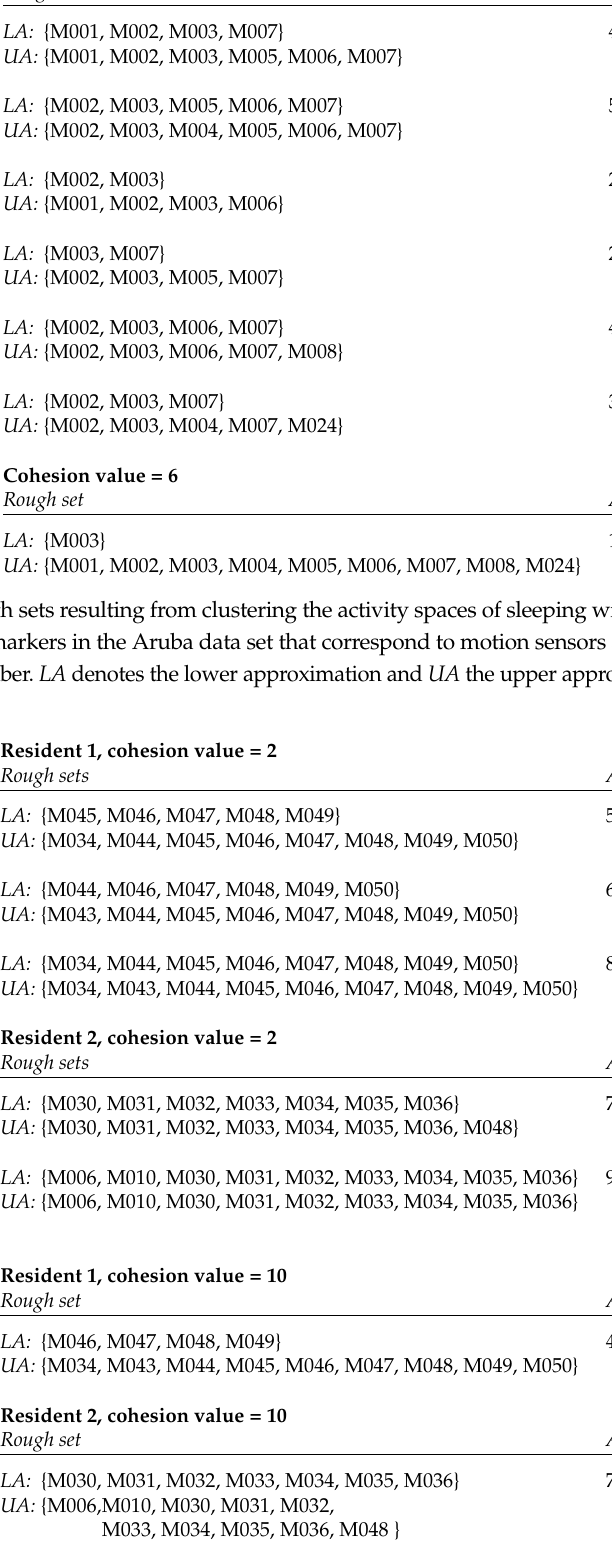
Figure 3. Rough sets resulting from clustering the activity spaces of two residents wandering in the smart home with cohesion values 2 and 10. The data set used for this analysis is the CASAS twor.2010 data set. LA denotes the lower approximation and UA the upper approximation of the rough